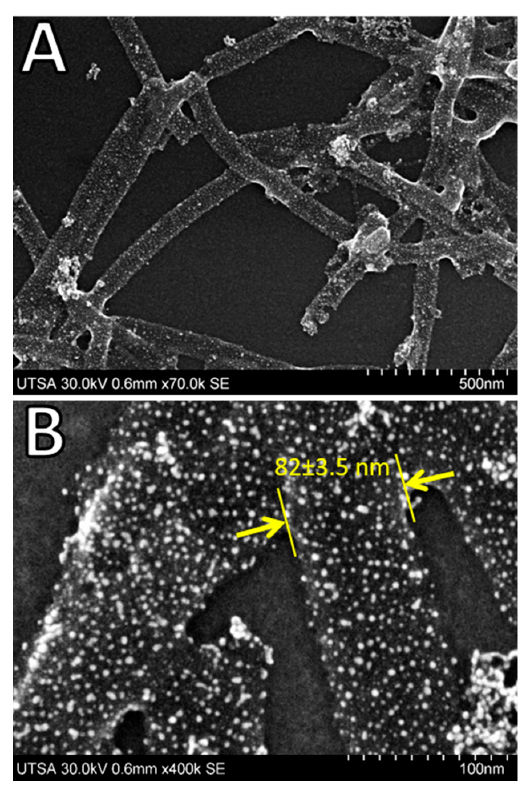
Figure 2. FE ‐ SEM imaging of VP6 ‐ Pd. ( A ) Low magnification SEM. ( B ) High magnification SEM, Figure 2. FE-SEM imaging of VP6-Pd. ( A ) Low magnification SEM. ( B ) High magnification SEM, indicating nanotube diameter of 82 ± 3.5 nm. Imaging with UHR ‐ FE ‐ SEM HITACHI, operated at an indicating nanotube diameter of 82 ± 3.5 nm. Imaging with UHR-FE-SEM HITACHI, operated at an accelerating voltage of 30 kV. accelerating voltage of 30 kV. Metals 2016 , 6 , 200